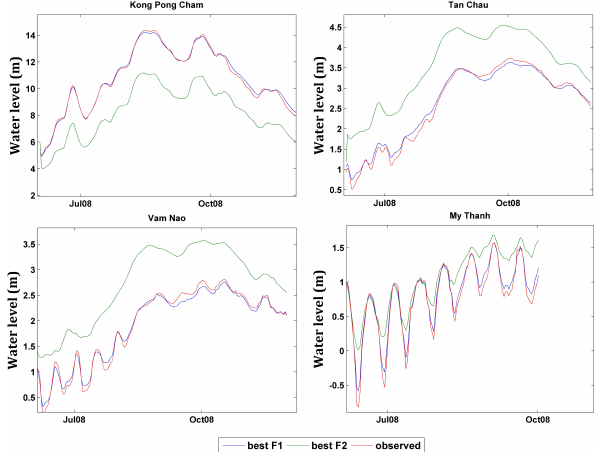
Fig. 11. Observed and simulated hydrographs for best solutions for F1 and F2 for selected gauging